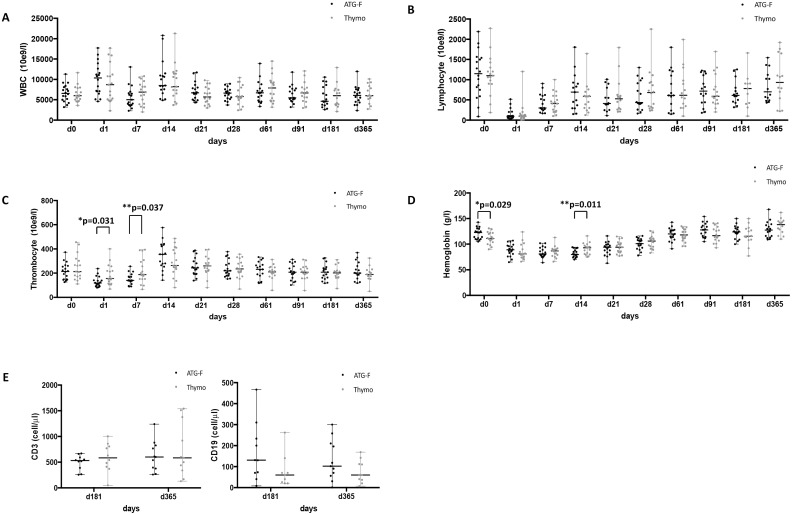
Hematological values during follow-up (A) Median white blood cells (WBC) count, (B) Median lymphocyte count, (C) Median thrombocyte count, (D) Median haemoglobin, (E) Mediant T- (CD3+) and B- (CD19+) cell count.